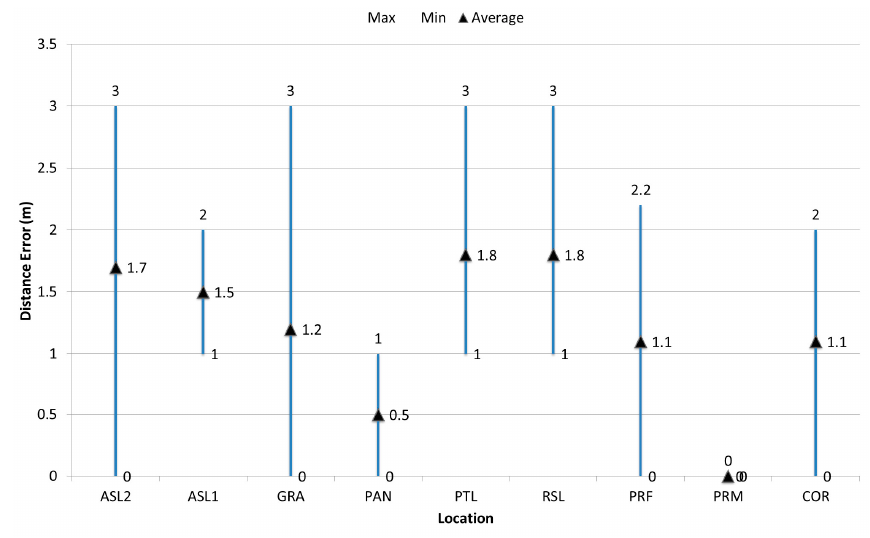
Figure 14. Average distance error per the test-bed layout.